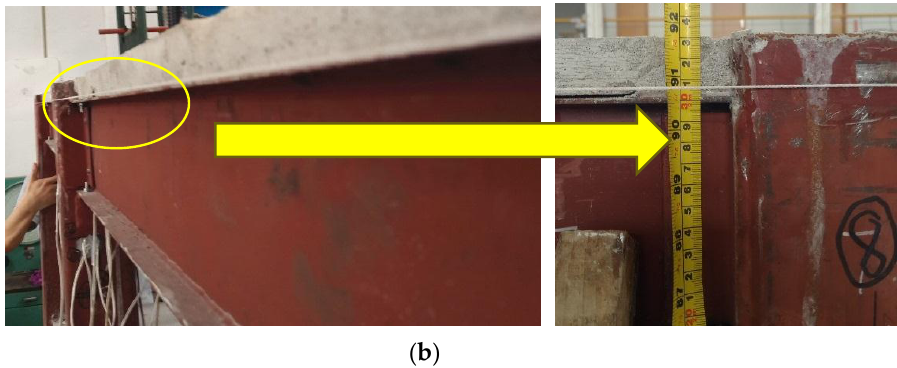
Figure 12. The vertical deformations at the end of case G6. ( a ) Model A; and ( b ) Model B.